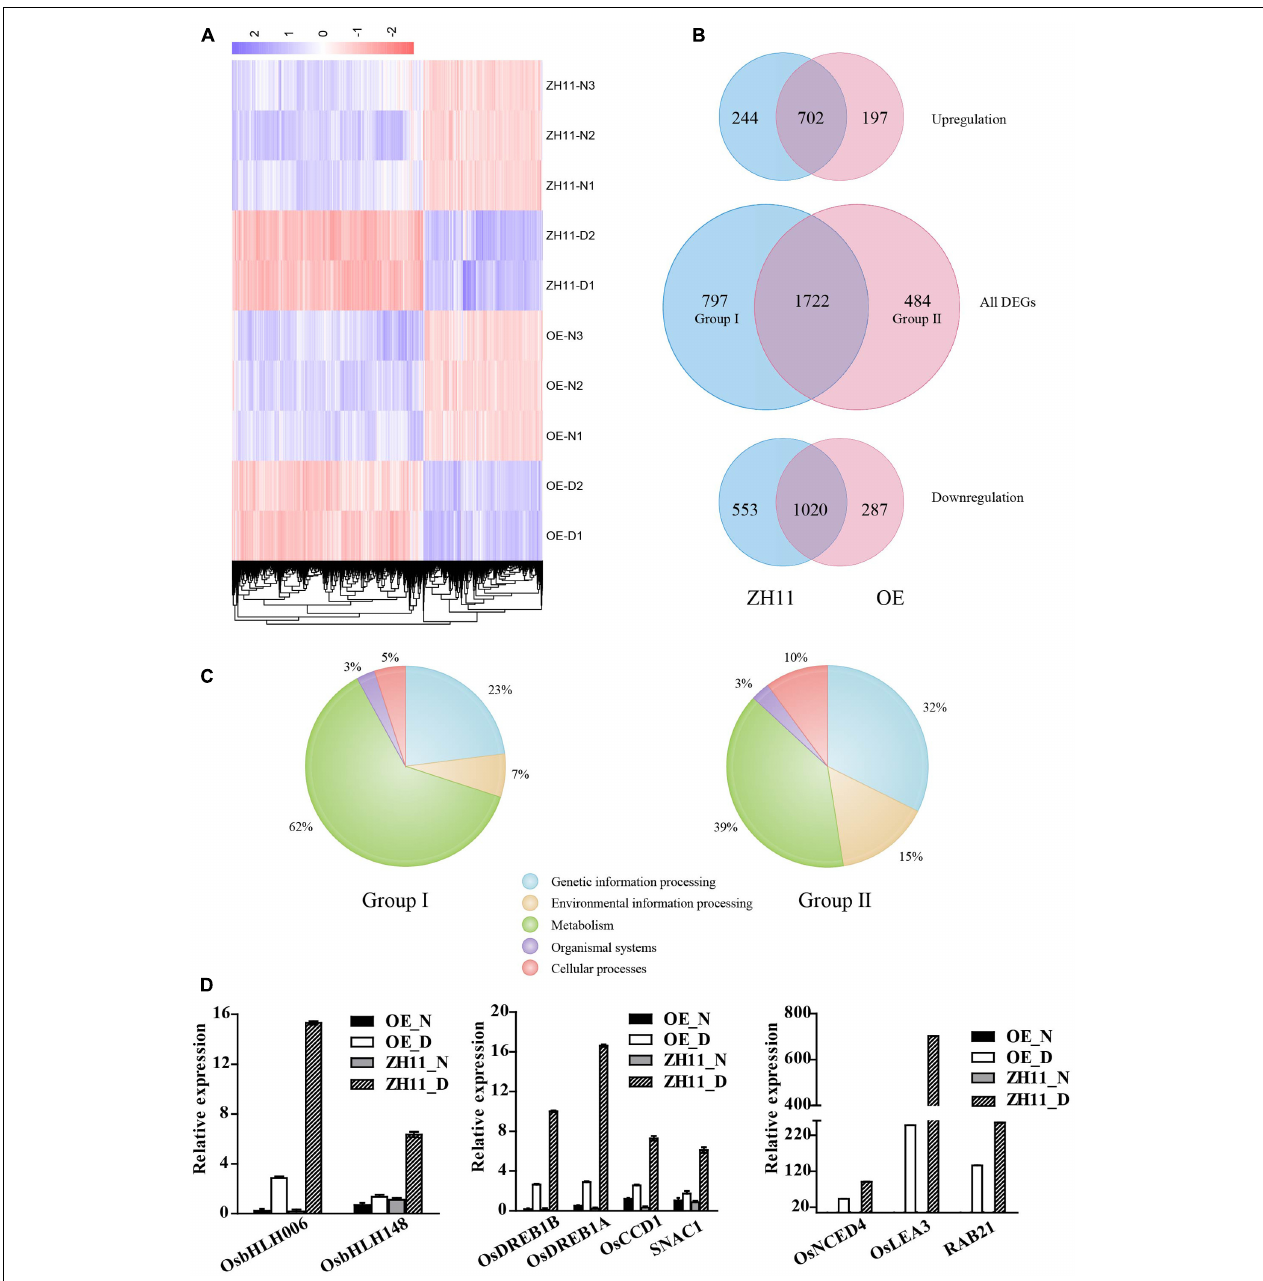
FIGURE 6 | Transcriptome profiling of OsJAZ1 -OE plants. (A) The expression patterns of the DEGs under normal (–N) and drought stress conditions (–D). Color scale is in log 2 of the fold change. (B) Number of specific and common drought-responsive DEGs in the WT and OE plants. (C) KEGG classification of the specific drought-responsive DEGs (Group I and Group II) in the WT and OsJAZ1 -OE plants. (D) Confirmation of several genes involved in the ABA and JA pathways and stress resistance showing lower drought-induced levels in the OsJAZ1- OE plants than in WT ZH11. Error bars represent the SE of three replicates.